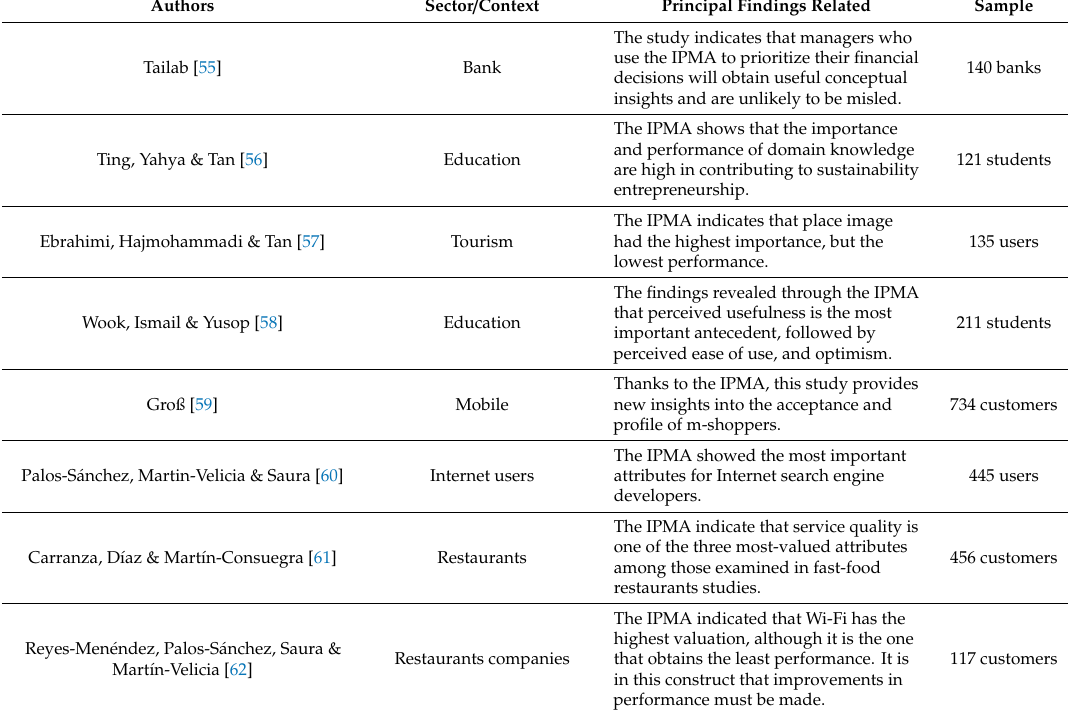
Table 1. Importance-Performance Matrix Analysis (IPMA)